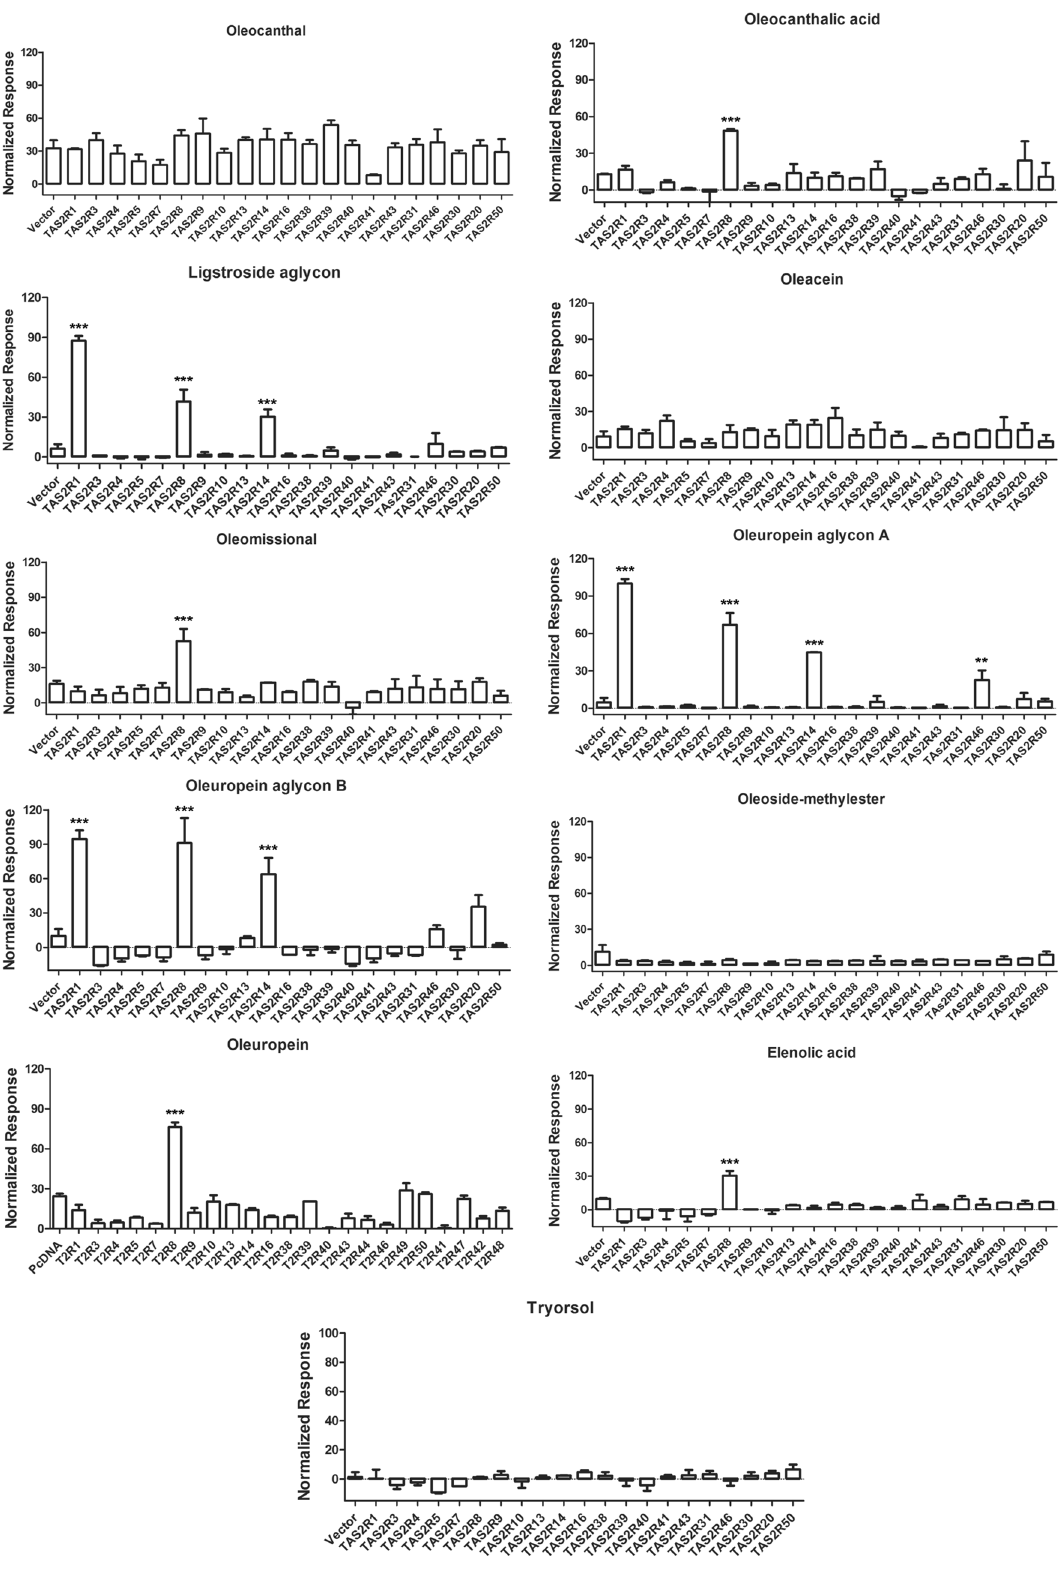
Figure 3. Phenolic compound bitter taste activity tests on hTAS2Rs. Relative fluorescence signals caused by phenolic compound activation of the receptors and the empty vector as a negative control. The concentration of the compounds used was [300 µM], except for Ligstroside aglycon and Oleuropein aglycon [200 µM], oleuropein that was [3 mM]. The asterisks indicate significant differences tested by one-way ANOVA (*** p < 0.0001) (N = 2). Data represent mean ±